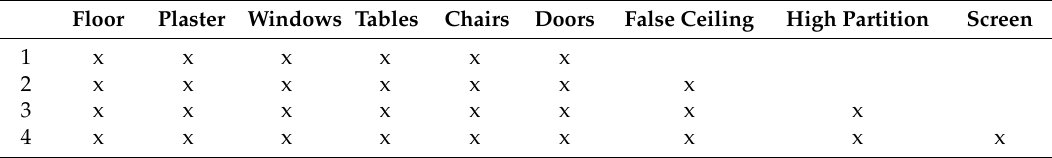
Table 4. The configurations analyzed for each of the six office typologies.